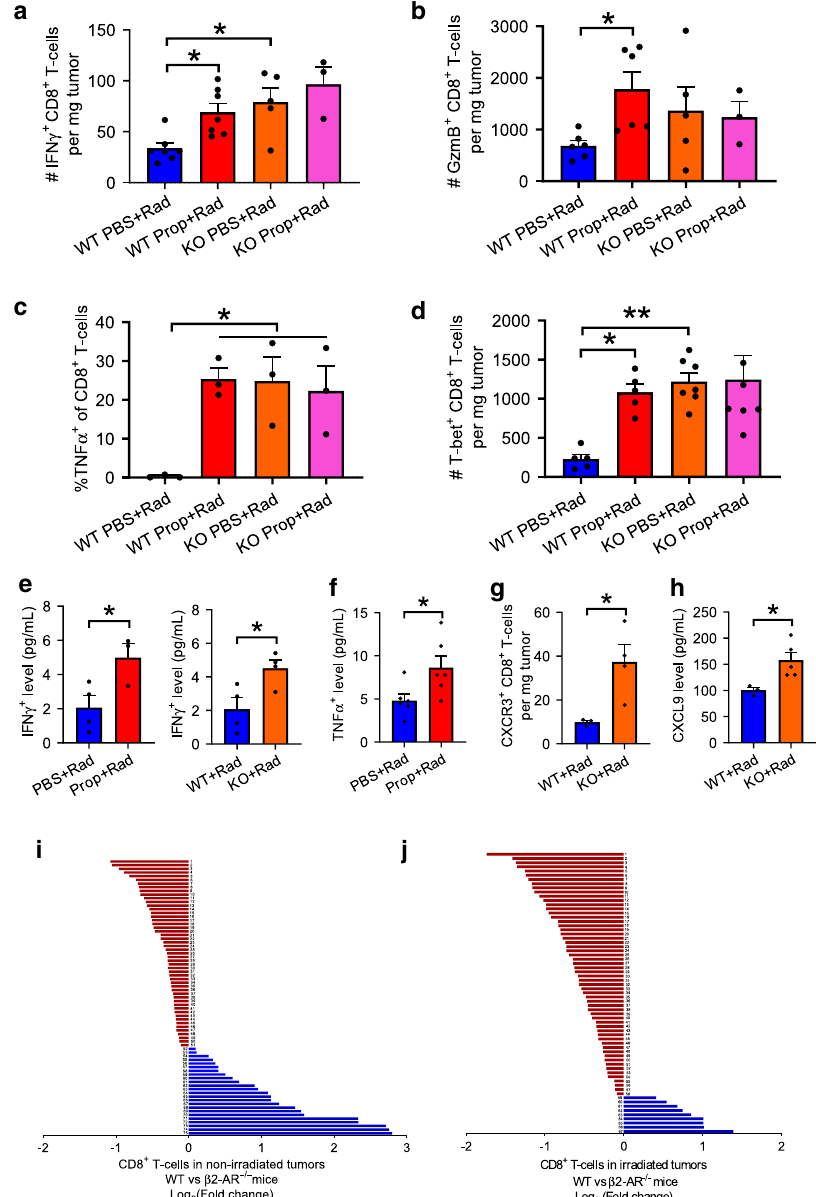
Fig. 3 Blocking/absence of β 2-adrenergic signaling increases expression of genes involved in enhancing the cell-mediated anti-tumor immune response and T cell egress in non-irradiated CT26 tumors. Immune analyses were performed in non-irradiated tumors of irradiated WT or β 2-AR KO mice treated with or without propranolol. Reduction or absence of β 2-adrenegic signaling increased the expression of important effector molecules in CD8 + T cells including: a IFN γ + , b GzmB + , c TNF α + , and d T-bet + . The level of IFN- γ was detected in serum of irradiated WT mice treated with or without propranolol ( e , left panel) or irradiated WT and β 2-AR KO mice ( e , right panel) as well as TNF α in irradiated mice treated with or without propranolol f . The expression of CXCR3 in non-irradiated tumors g and the level of CXCL9 in serum h was detected in irradiated WT or β 2-AR KO mice. i and j Gene pro fi les with NanoString in CD8 + T cells (data are presented as Log 2 (fold change of WT/KO)) of the non-irradiated tumors i and irradiated tumors j from WT and β 2-AR KO mice which had been given radiation to the contralateral tumors. Detailed information is shown in Supplementary data 1. Data are presented as mean ± SEM. * P < 0.05; ** P < 0.01 (one-way ANOVA analysis for a – d ; Student ’ s t test a nalysis for e – h ). For a , n = 7 biologically independent mice in WT PBS + Rad and WT Prop + Rad groups, n = 5 in KO PBS + Rad group, n = 3 in KO Prop + Rad group; for b , n = 6 biologically independent mice in WT PBS + Rad and WT Prop + Rad groups, n = 5 in KO PBS + Rad group, n = 3 in KO Prop + Rad group; for c , n = 3 biologically independent mice in all groups; for d , n = 5 biologically independent mice in WT PBS + Rad and WT Prop + Rad groups, n = 7 in KO PBS + Rad and KO Prop + Rad groups; for e , n = 4 biologically ind e pendent mice in PBS + Rad, WT + Rad, and KO + Rad groups, n = 3 in Prop + Rad group; for f , n = 6 biologically independent mice in all groups; for g , n = 3 biologically independent mice in WT + Rad group, n = 4 in KO + Rad group; for h , n = 3 biologically independent mice in WT + Rad group, n = 5 in KO + Rad group; for i and j , n = 8 biologically independent mice in WT + Rad and KO + Rad